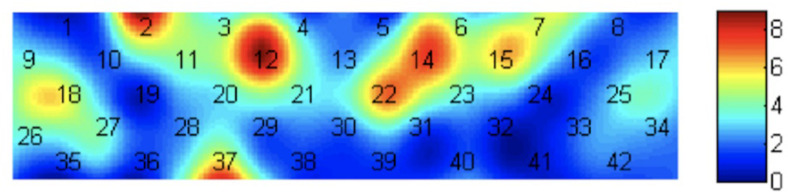
Heat map of the F value significant interaction between group and photograph type.